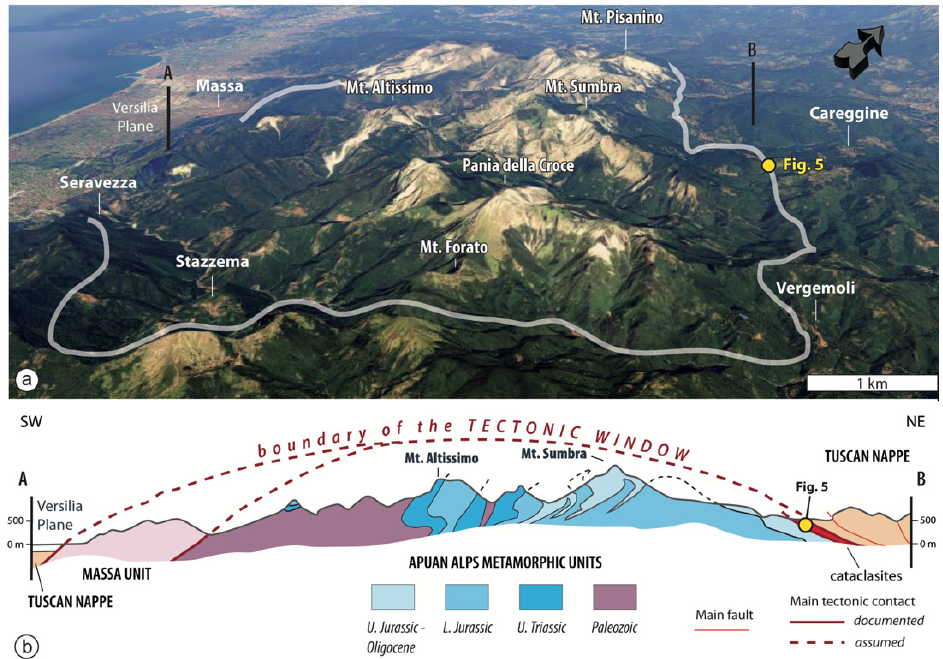
Figure 4. The Apuan Alps tectonic window geosite. ( a ) The Apuan Alps tectonic window (inside the white line) seen from south-east (Google Earth image). A and B represent approximatively the limit of the geological cross-section of ( b ); ( b ) Geological cross-section of the Apuan Alps tectonic window (modified after Carmignani and Kligfield, [30]).